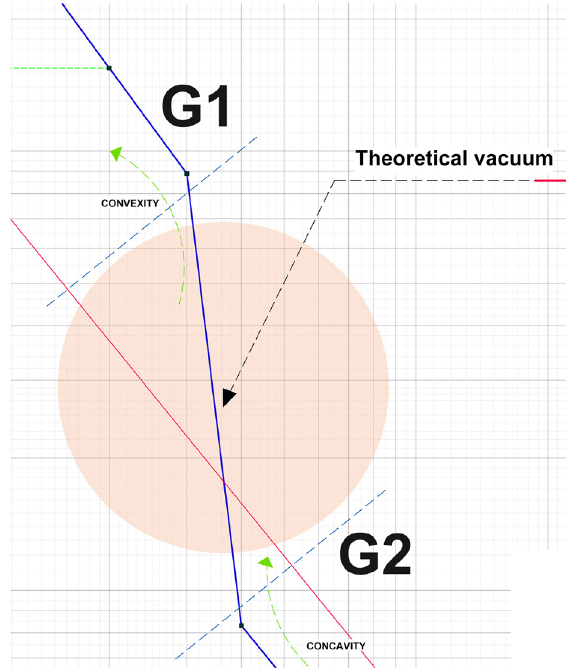
Fig. 11. The gap between the levels of Groups 1 and 2 of the hierarchical distribution of